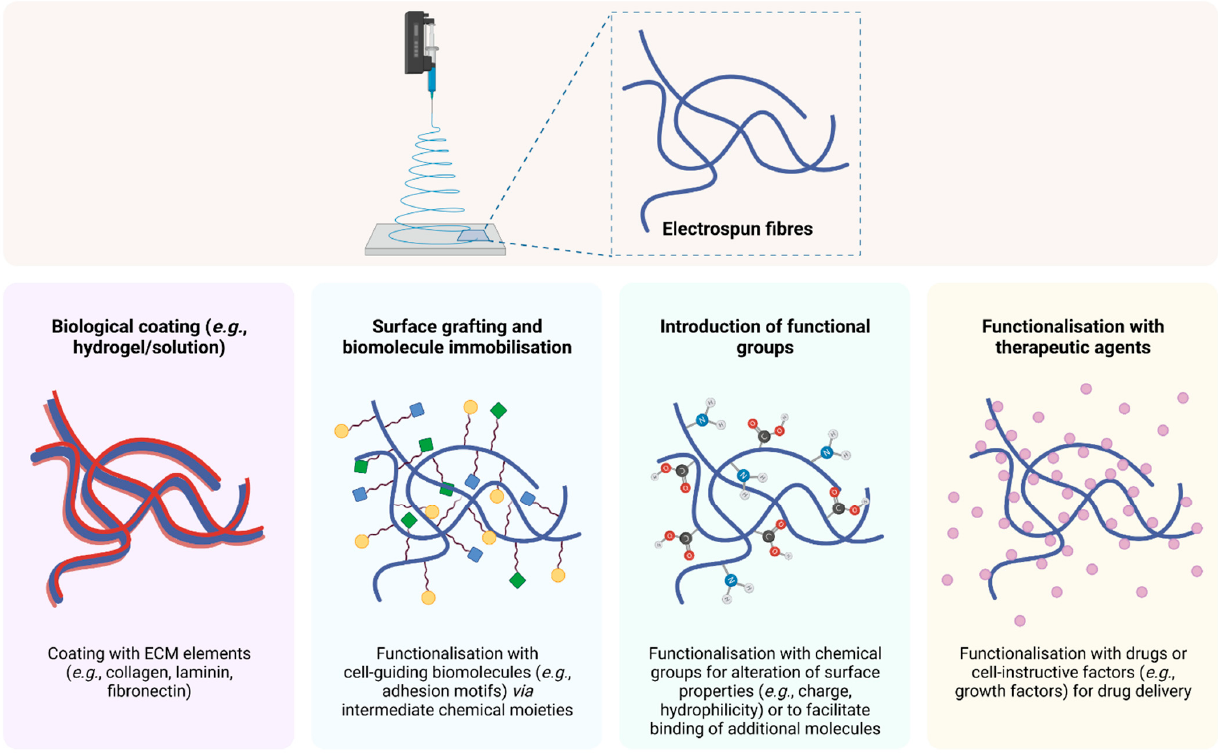
Figure 8. Examples of post-fabrication surface modifications of electrospun fibres. These can be obtained by physical or chemical modification techniques, such as plasma treatment or wet chemistry. Created with BioRender.com (accessed on 9 June 2021).